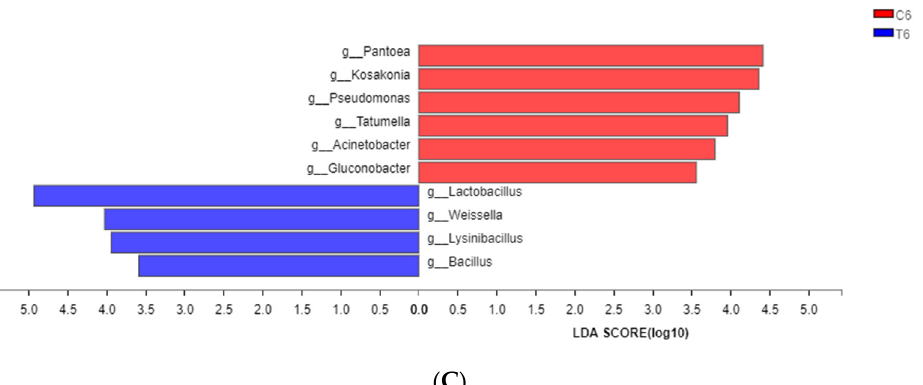
Figure 3. Comparison of genus differences in the bacterial communities between the two groups on Days 10 ( A ), 30 ( B ), and 45 ( C ) of ensiling: C, whole-plant corn silage without inoculum; T, whole-plant corn silage treated with Bacillus subtilis . The numbers 4, 5, and 6 represent 10, 30, and 45 days of ensilage time.